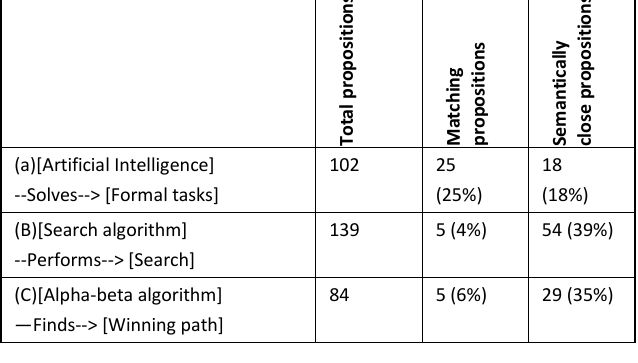
N UMBER OF E XACTLY M ATCHING AND S EMANTICALLY C LOSE P ROPOSITIONS